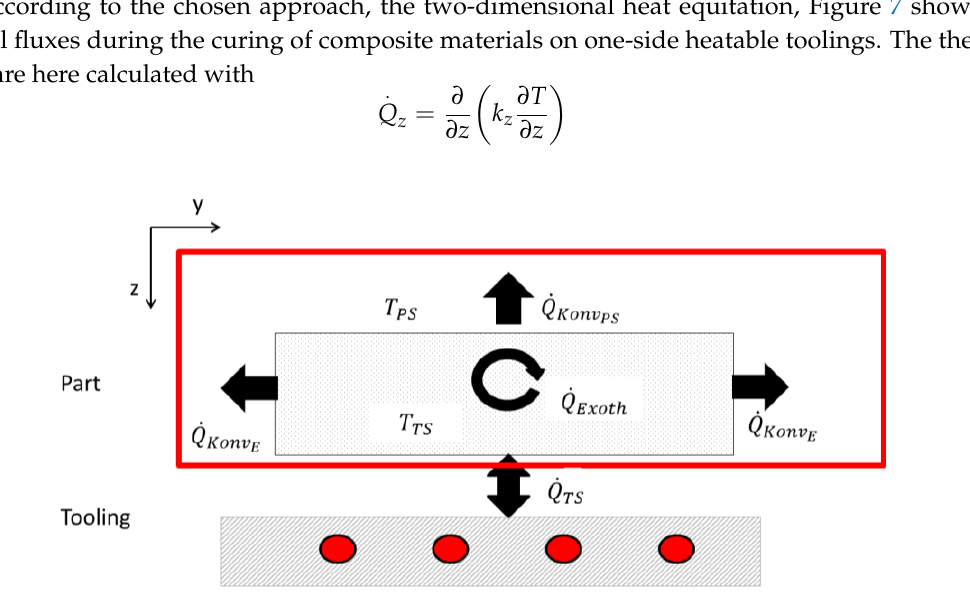
Figure 7. Schematic sketch of thermal fluxes.